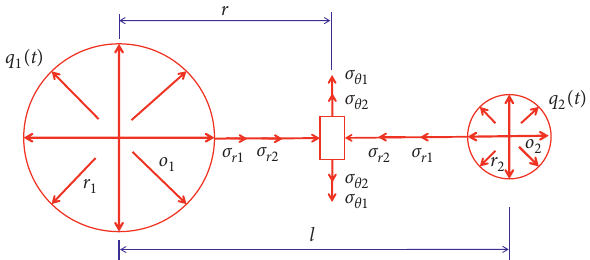
Figure 4: Mechanical model of double-hole swelling and fracturing: O